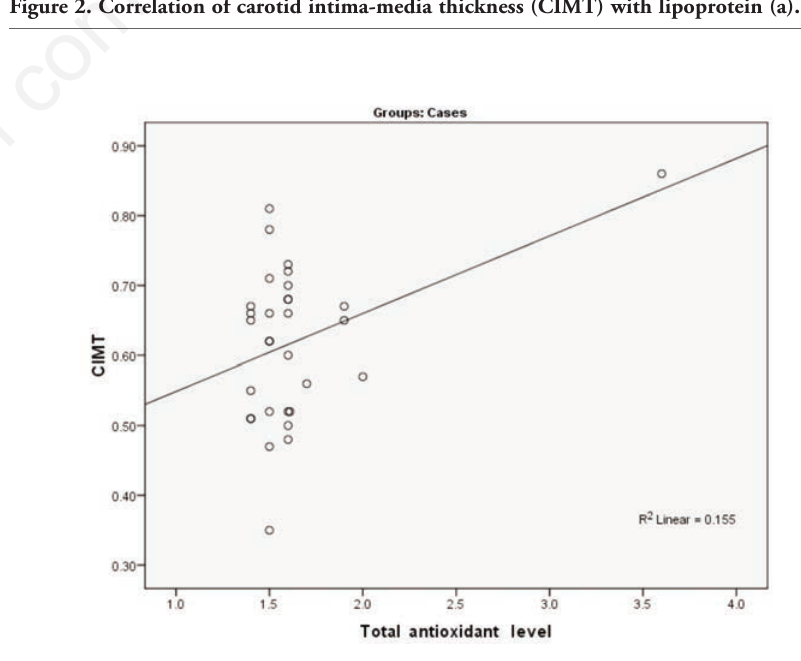
Figure 3. Regression analysis depicting correlation between carotid intima-media thick- ness (CIMT) and total antioxidant